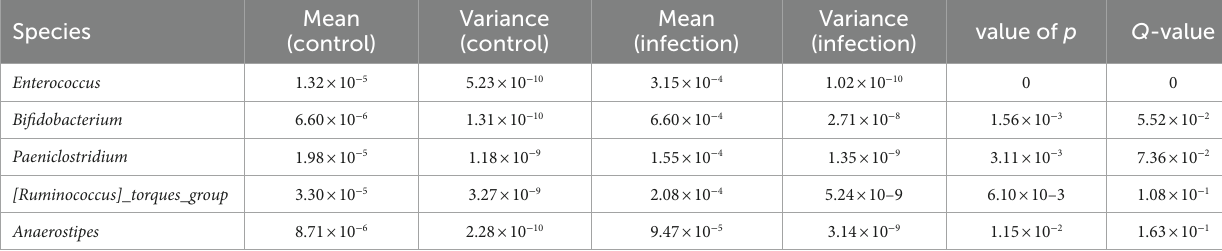
TABLE 1 Significantly different species of intestinal microbes of Chinese sea bass after infection. Species